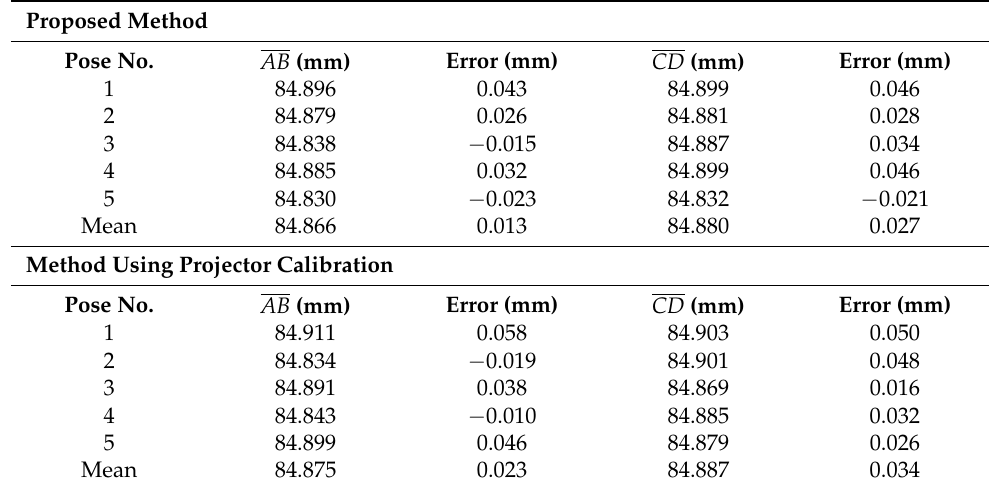
Table 1. Measurement results of two lines on the calibration